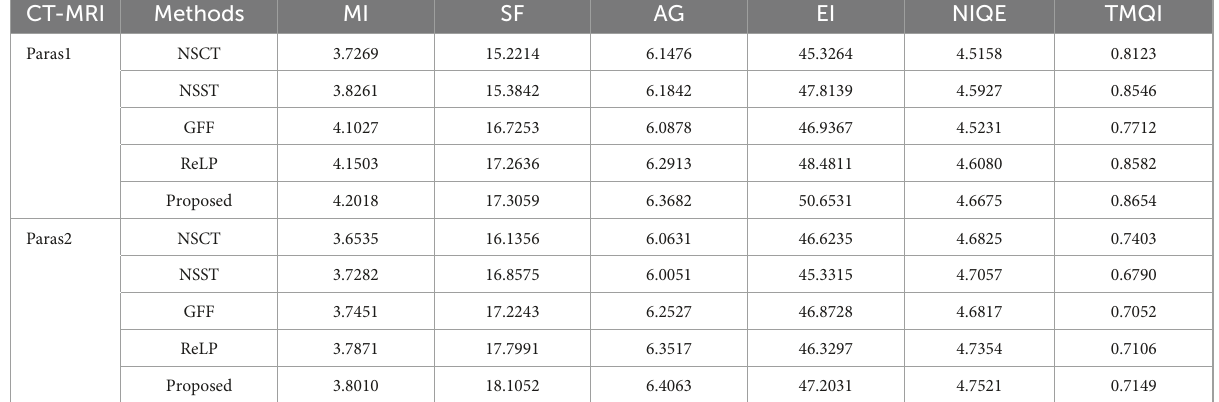
TABLE 2 Average values of index evaluation of different fusion methods for